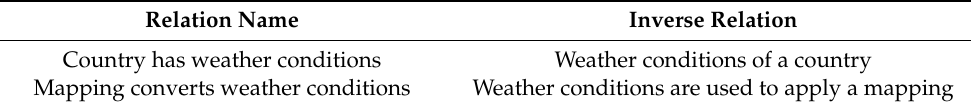
Table 4. Reverse relations of ad hoc binary relations from RustOnt.